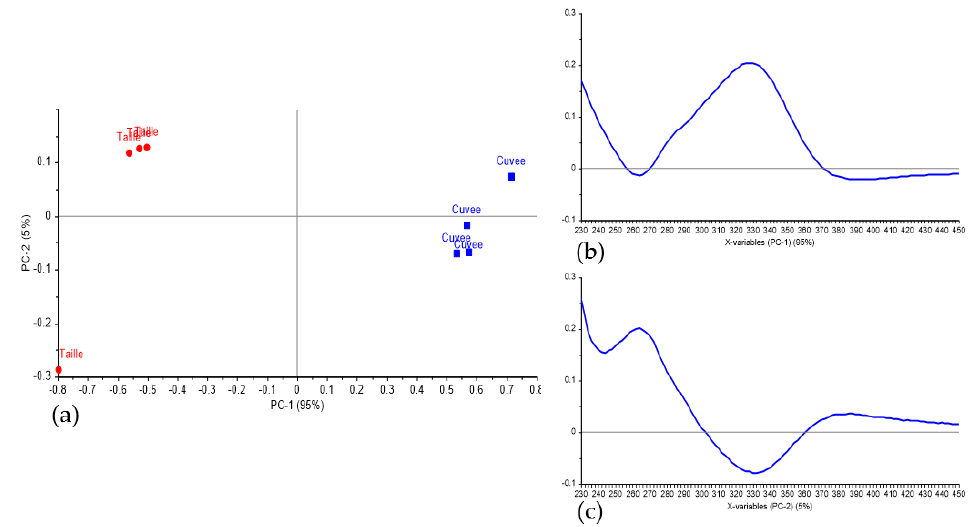
Figure 2. PCA scores and loadings plots of 2011 Chardonnay juice samples from the laboratory scale trial discriminating cuvée from taille . Scores plots ( a ); PC 1 ( b ) and PC 2 ( c ) loadings. For Pinot noir samples, PC 1 accounts for 84% of the data variability (Figure 3a), and similar to